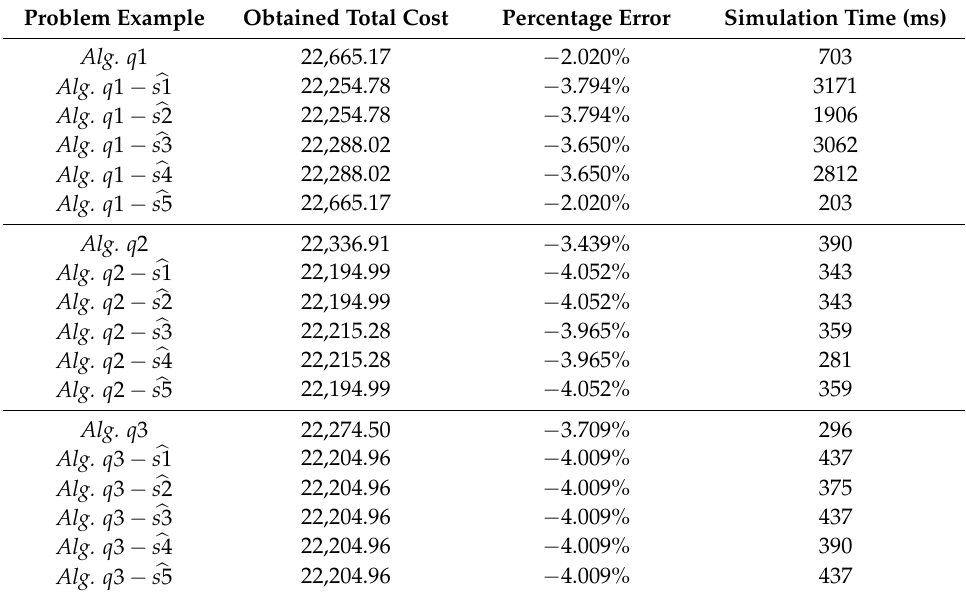
Table 8. Obtained results for irregular network GIr-1 (Suboptimal cost 23,132.40).